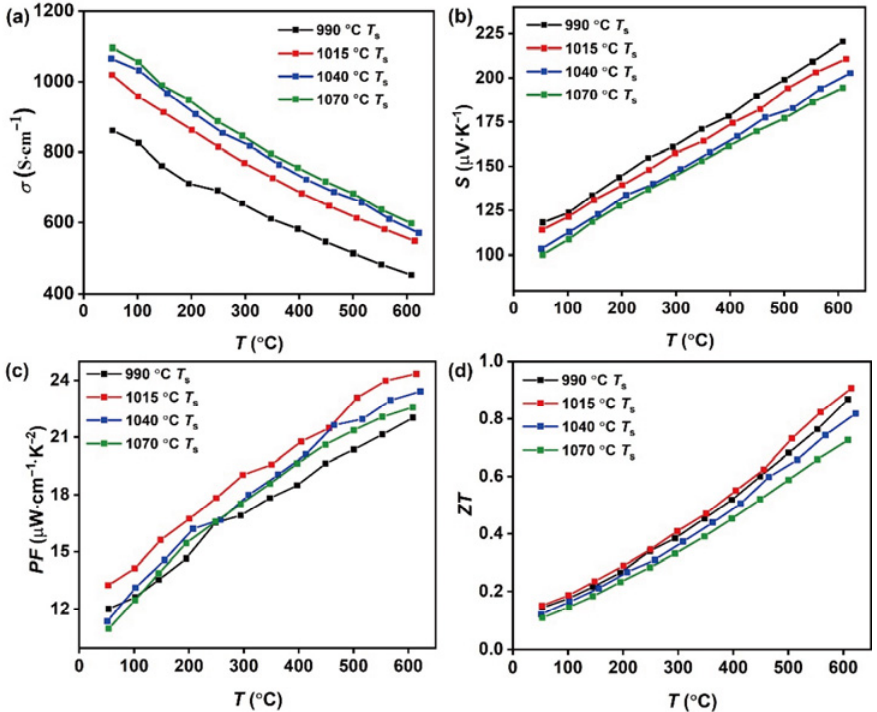
Fig. 9 Temperature-dependent TE properties for different T s (990, 1015, 1040, and 1070 ℃ ) of SPS: (a)  , (b) S , (c) PF , and (d) ZT